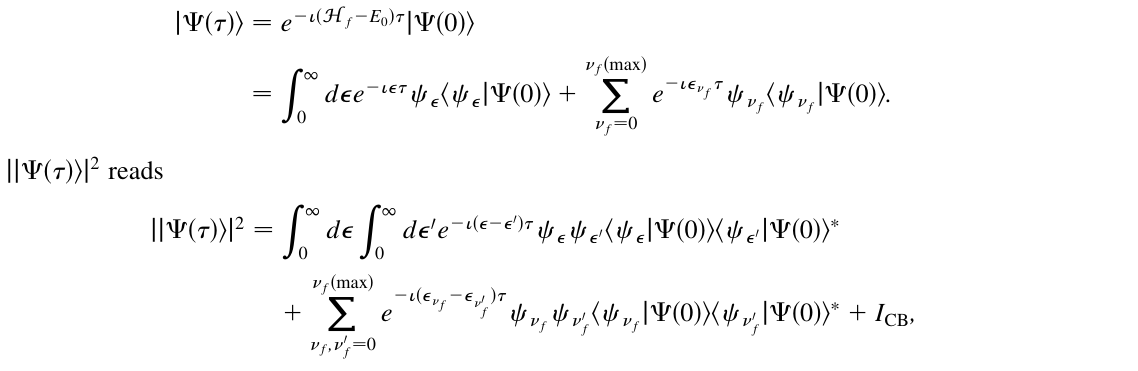
FIG. 12. The time-dependent dynamics of the vibrational wave packets in the final 1 2 (cid:2) excitations to the vibrational sublevels (cid:3) ¼ 0 ; . . . ; 3 of the core-excited